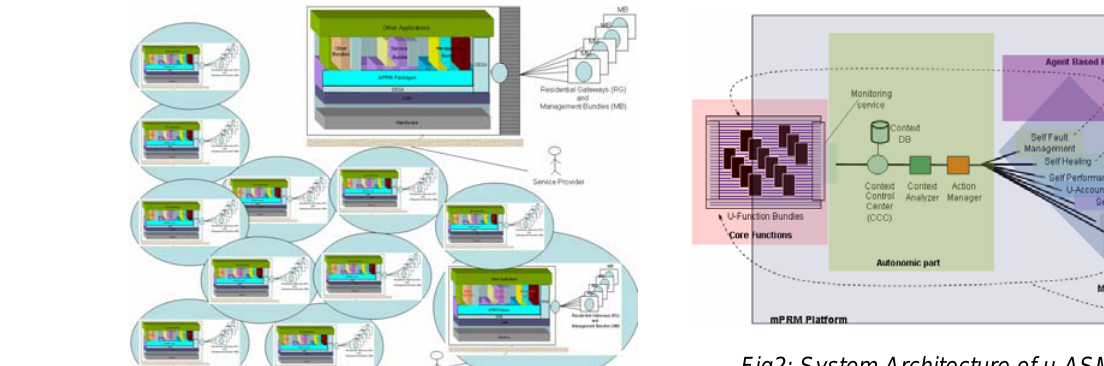
Fig2: System Architecture of u-ASM